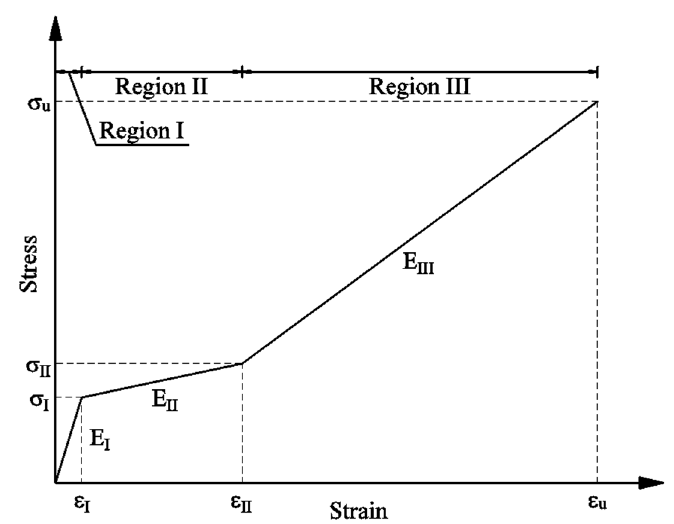
Figure 13. Characteristic stress–strain response curve of composite specimens.